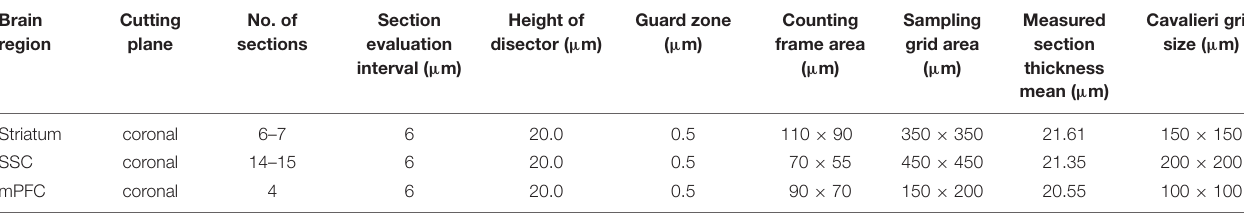
TABLE 1 | Stereological sampling parameters.